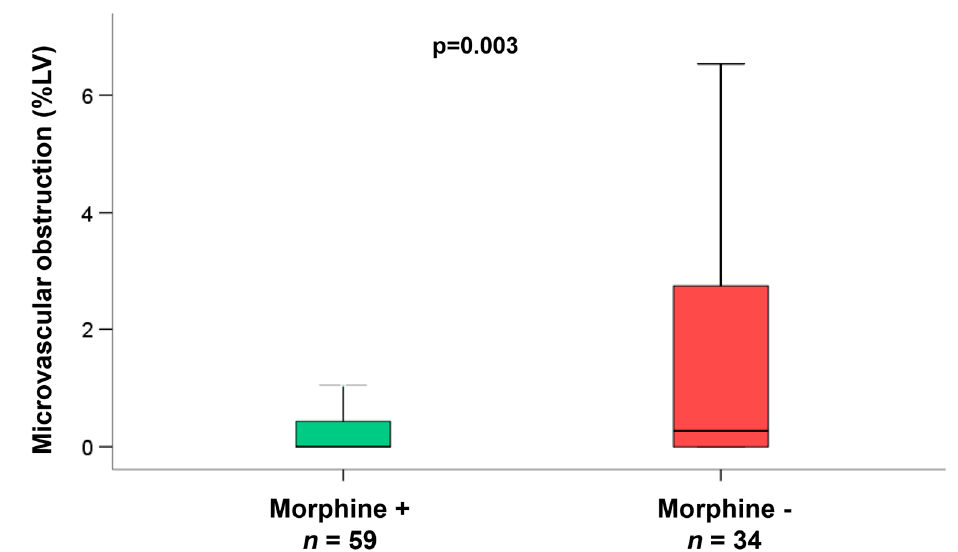
Figure 3. Microvascular obstruction in subgroup of patients with reperfusion within 120 min/2 h and TIMI-flow ≤ 2 before PCI. Observed a significantly smaller area of microvascular obstruction in the group of patients additionally treated with morphine ( p = 0.003).